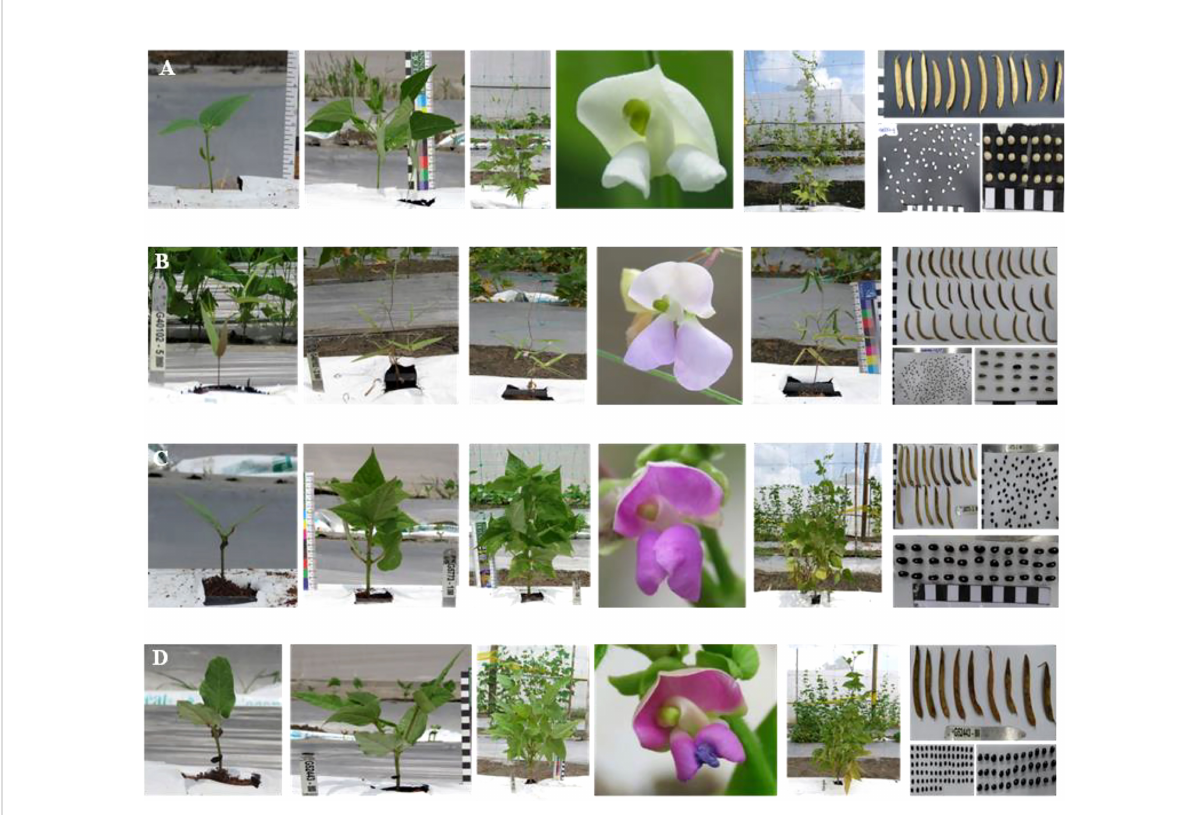
FIGURE 1 Phenotypic characteristics of the Phaseolus lines and interspeci fi c hybrid, from its initial stages until harvest. (A) P. acutifolius (G40001), (B) P. parvifolius (G40102), (C) P. vulgaris - ICA Pijao (G5773) and (D) Interspeci fi c hybrid (G52443 - INB 47). The fi gure shows the variation of morphological traits of the common bean accessions